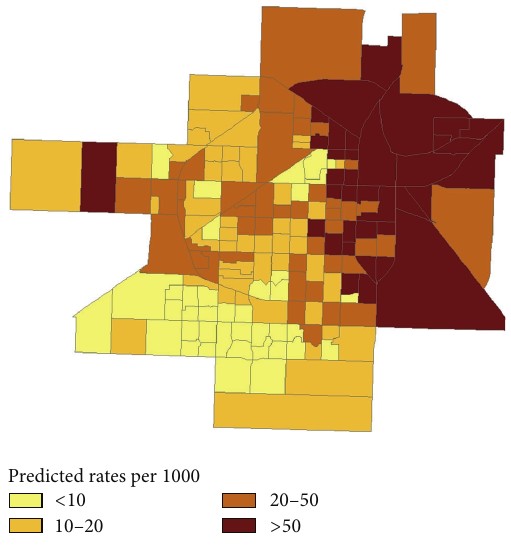
Figure 1: Violent crime rates (per 1000) modeled using Geographi- cal Weighted Regression, Lubbock, Texas, 2005–2009.